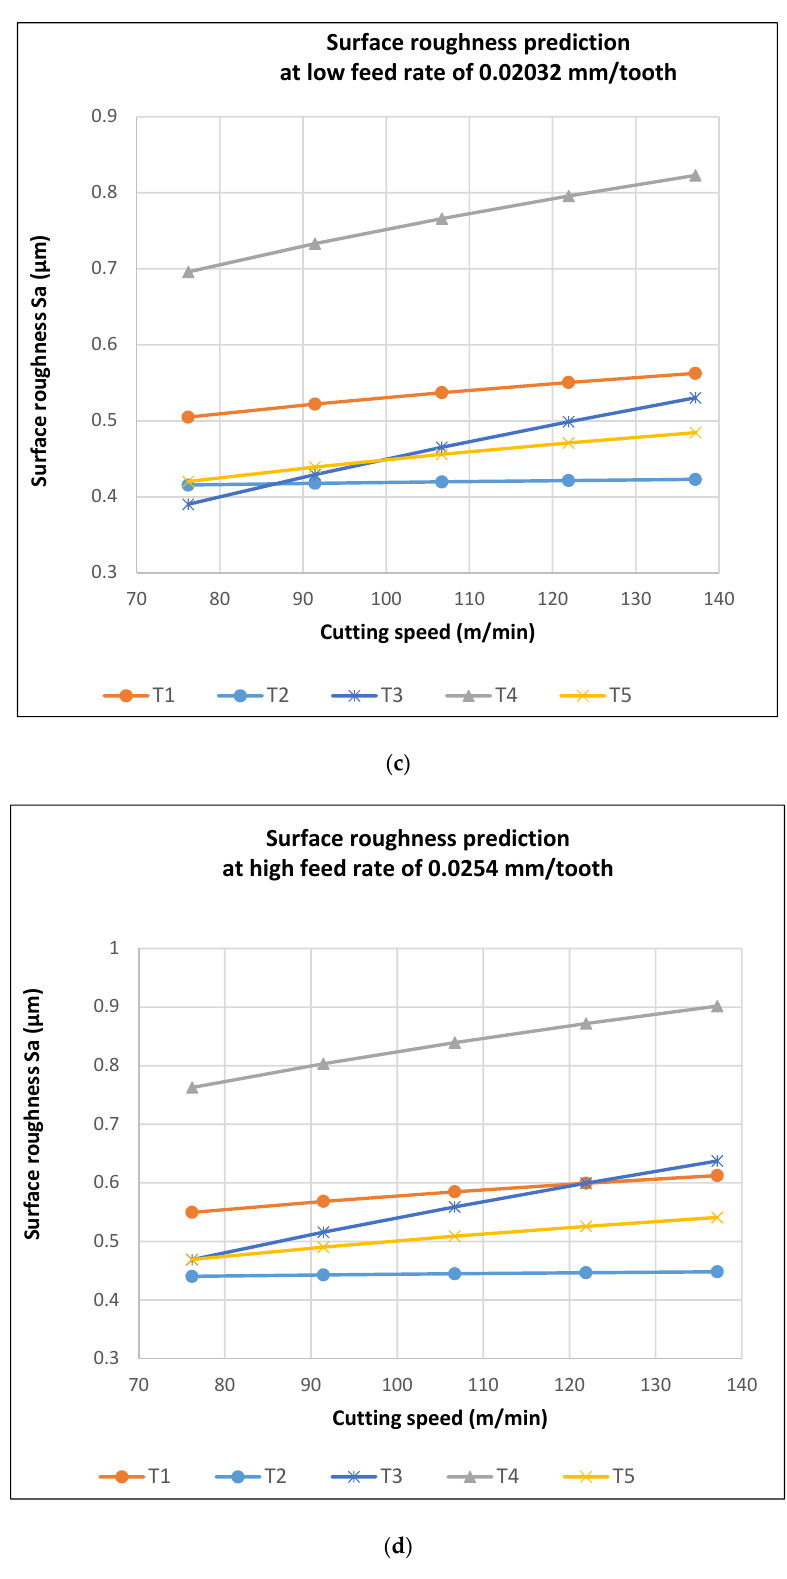
Figure 11. Roughness prediction trends from model equations. ( a ) at low speed of 76.2 m/min ( b ) at high speed of 137.16 m/min ( c ) at low feed of 0.02032 mm/tooth ( d ) at low feed of 0.0254 mm/tooth